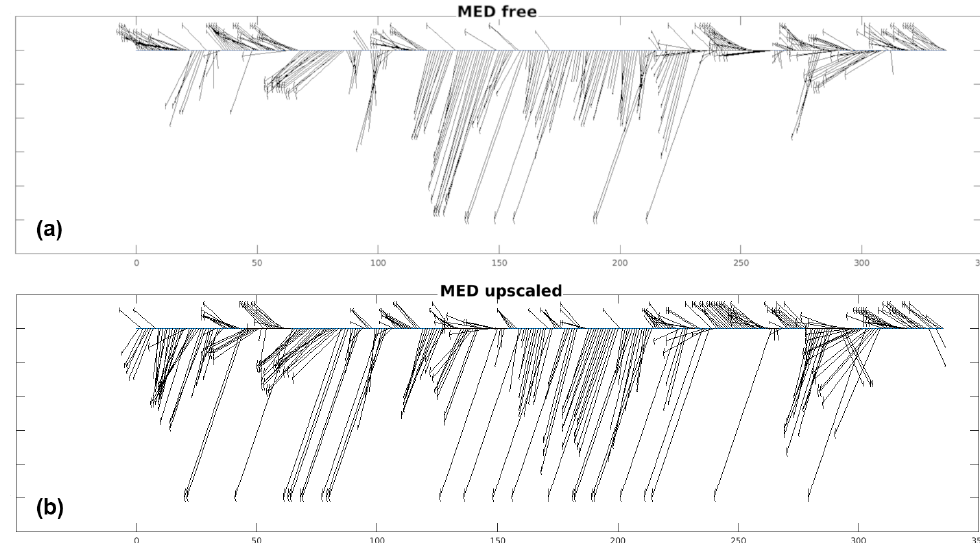
Figure 8. Rhône River plume direction and length (a) for the free and (b) upscaled MED models. The horizontal scale represents the days after the start of the upscaling experiment (February